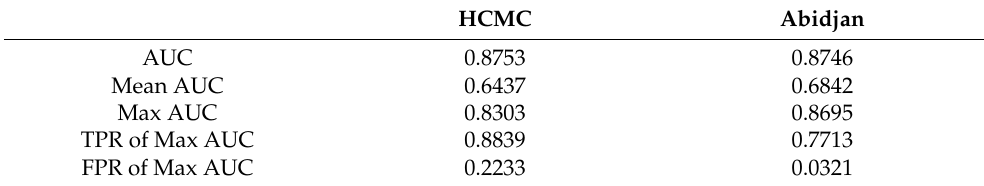
Table 3. Statistical results of ROC curves from HCMC and Abidjan.